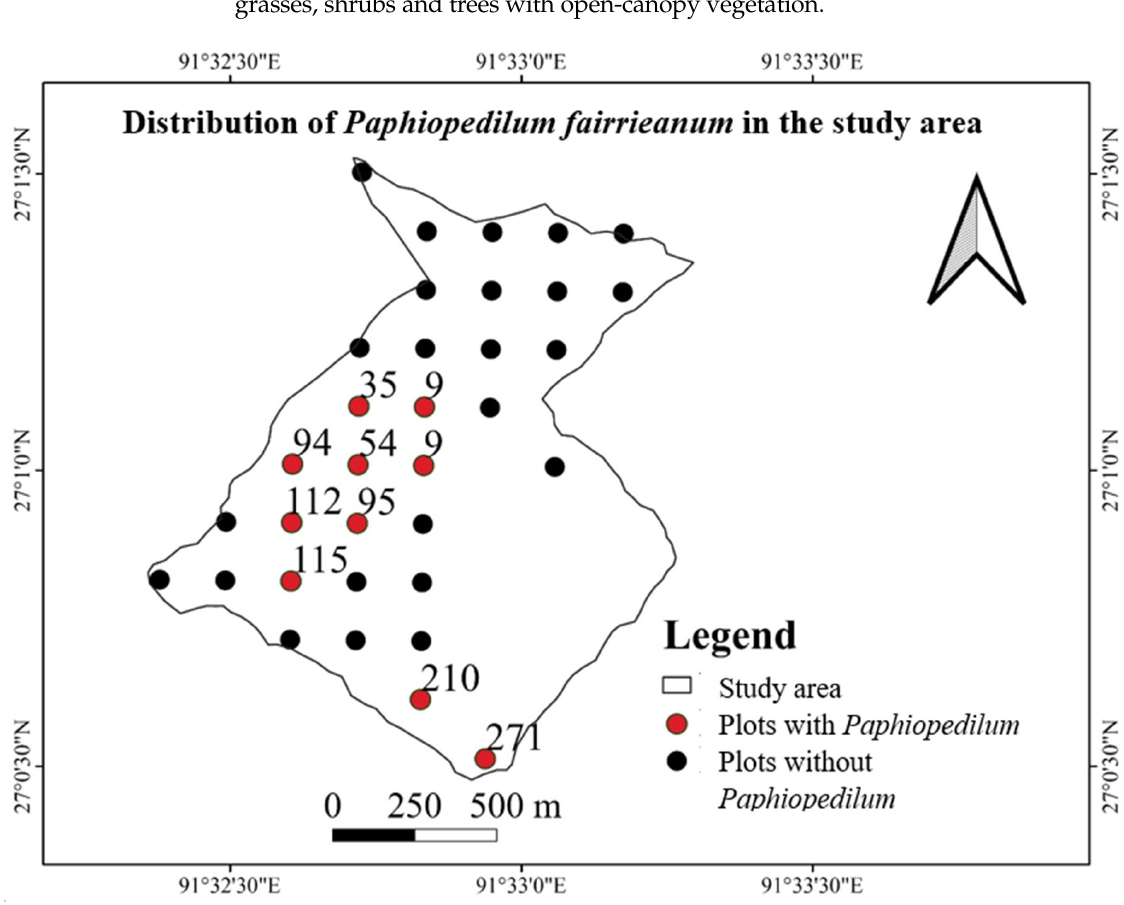
Figure 4. Spatial distribution of Paphiopedilum fairrieanum in the study area.